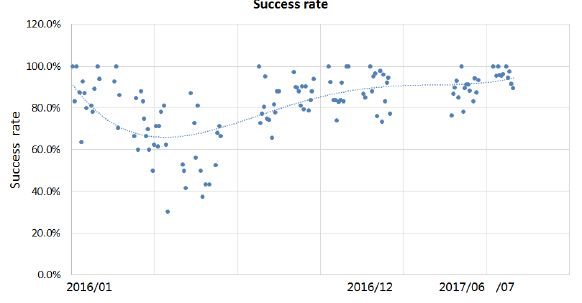
Fig. 19. The #1 gyrotron reliability when it is following EAST experiment.